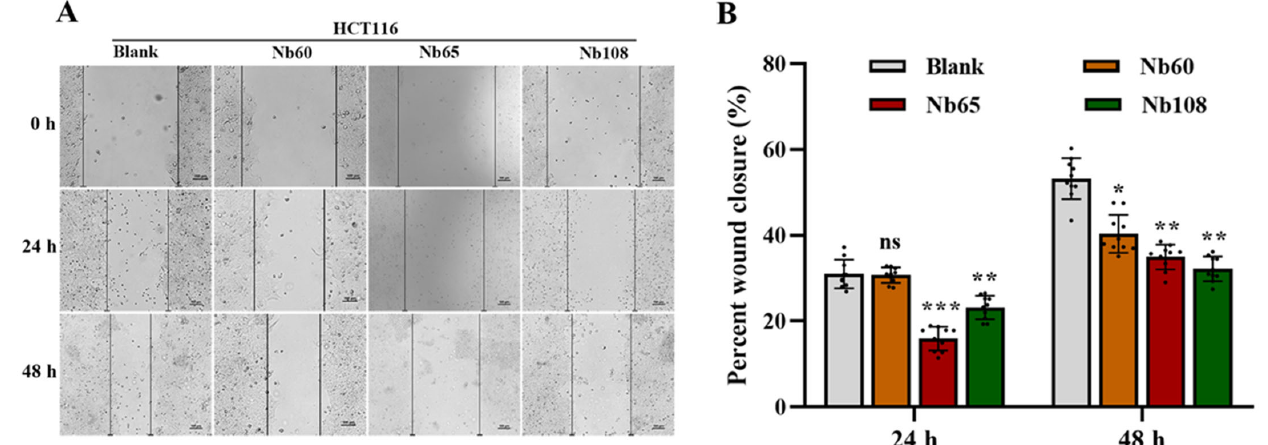
Figure 5. Determination of the inhibitory effect of Nbs in a wound healing assay. ( A ) The wound of the cells was recorded and displayed as indicated (0, 24 h, 48 h). ( B ) The wound healing percentage was indicated in a bar chart according to the wound healing width. The difference between the experimental and blank groups was analyzed using one-way ANOVA followed by Dunnett multiple comparison test. The data are shown as the mean ± SD, and significance was indicated as * p < 0.05, ** p < 0.01, *** p < 0.001.